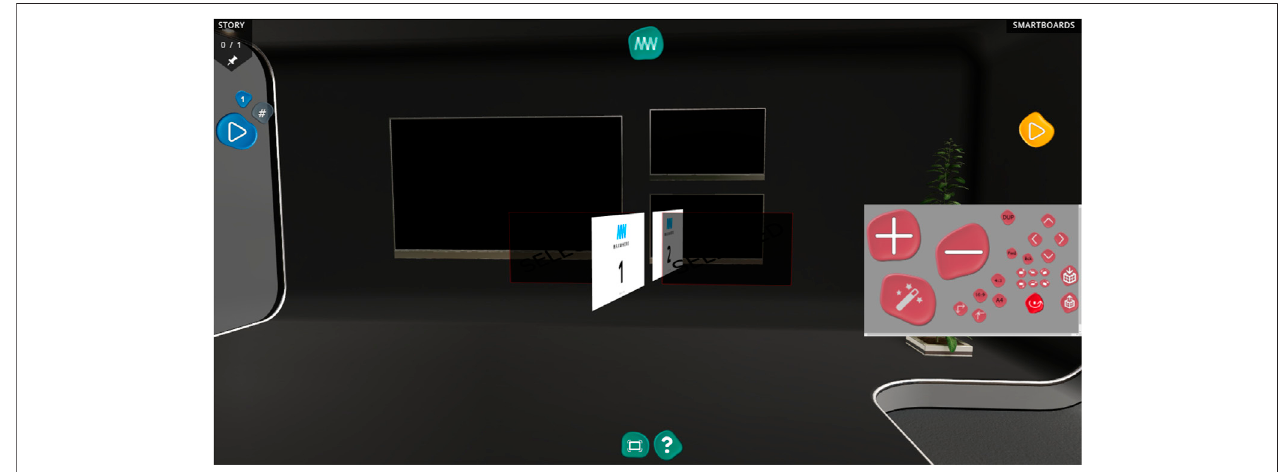
FIGURE 6 | Using the centroid pivot, it is possible to rotate a group of smartboards around their center of geometry. In this case, the original location of the two smartboards is indicated by the greyed out rectangles. As can be seen, both smartboards have been rotated towards the left around their center of geometry.